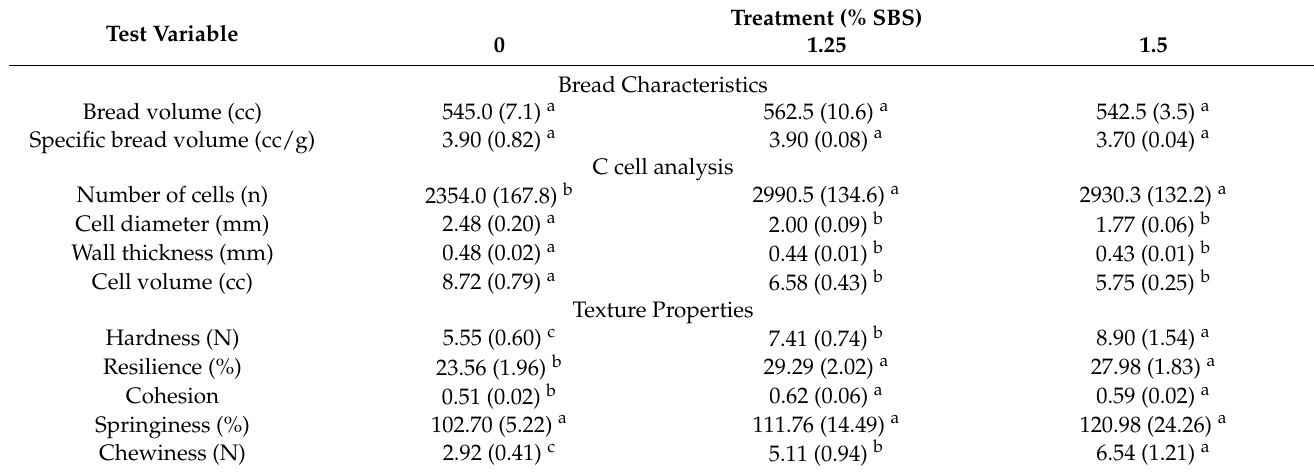
Table 7. Mean (SD) baking and bread characteristics of wheat flours.